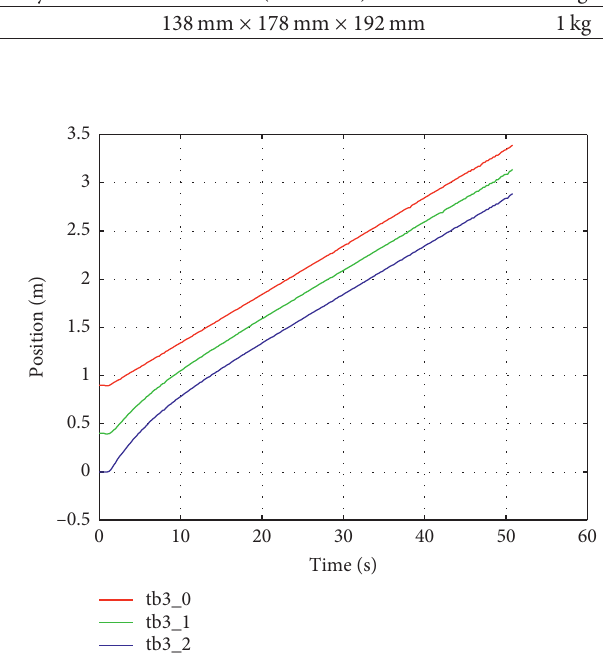
Figure 9: Positions of TurtleBot3 mobile robots in the